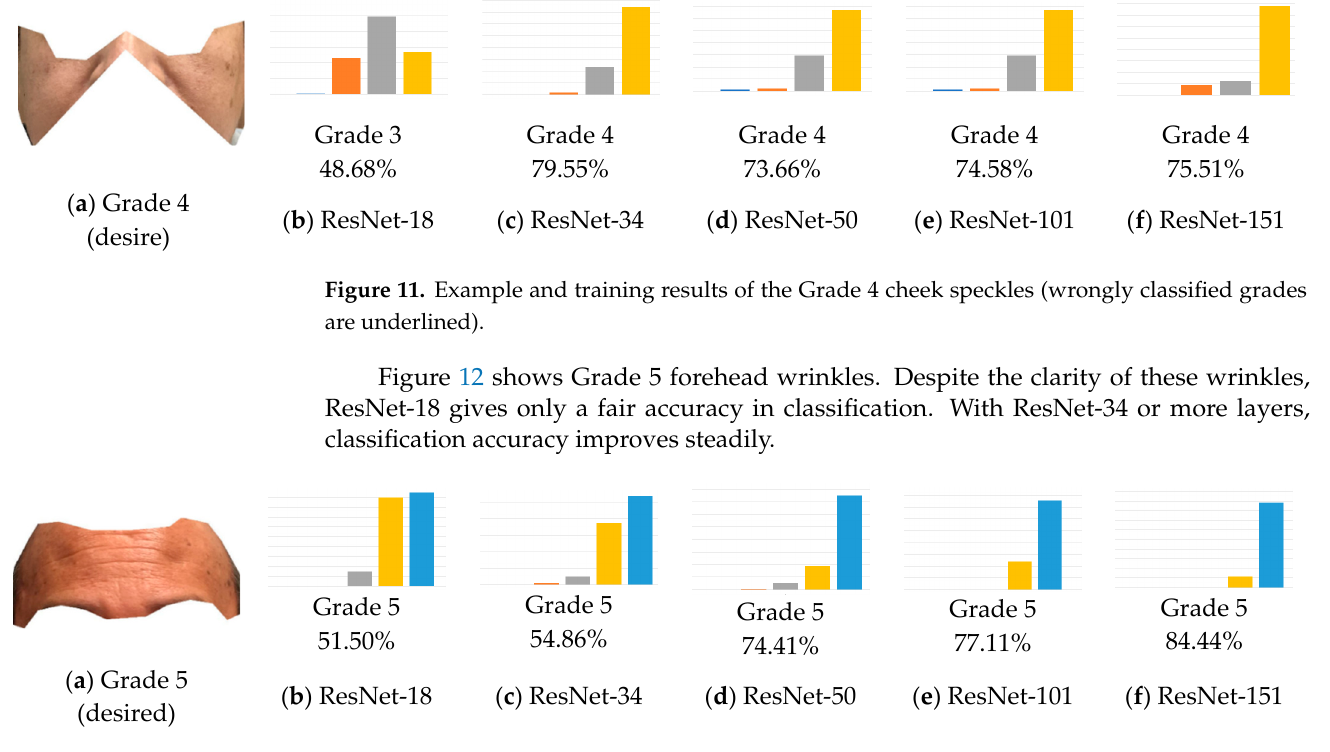
Figure 12. Example and training results of Grade 5 forehead wrinkles.